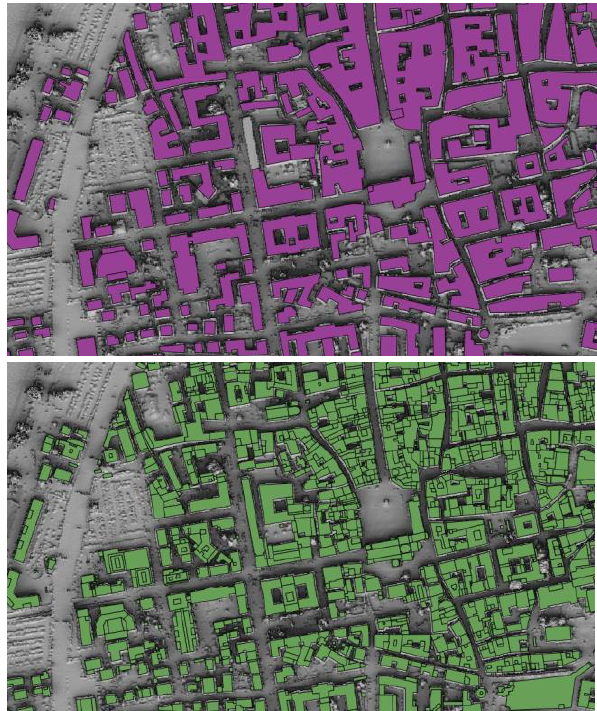
Figure 2. Example of used 1:10,000 map (top) and 1:1,000 (bottom) topographic